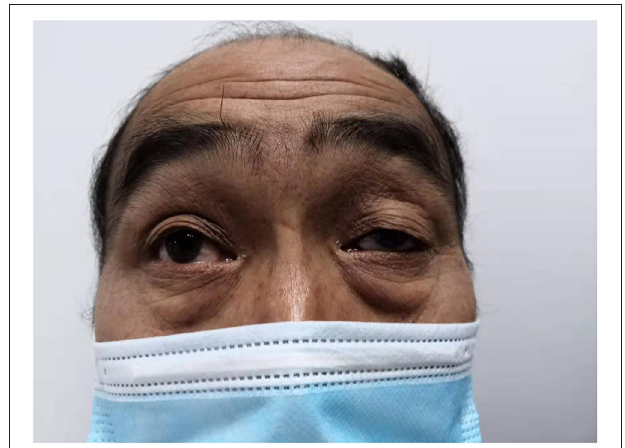
FIGURE 1 | Father had weakness of the left eyelid muscle.